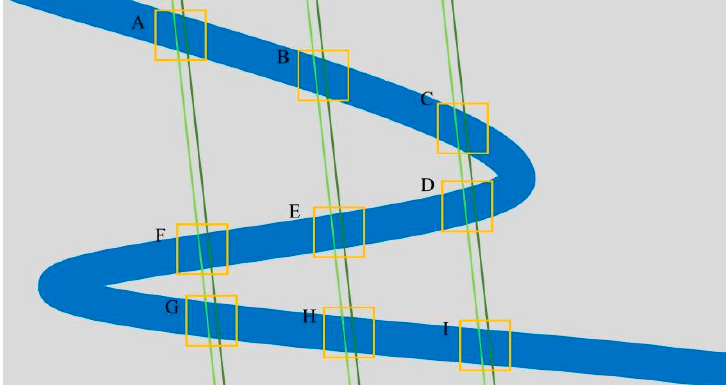
Figure 2. The river could have been passed over by the satellite more than once due to the course of the river; for each location at which ICESat-2 passes over the river, a unique ID was assigned. (A-I) indicates the position ID at the point where the track passes through the river. ( A – I ) indicates the position ID at the point where the track passes through the